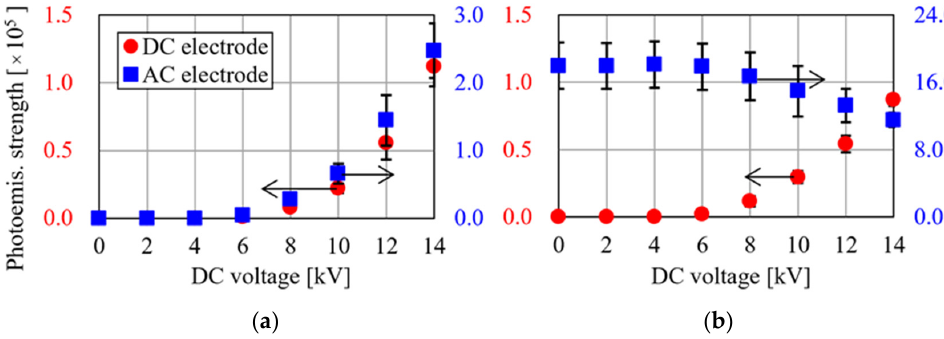
Figure 13. Photoemission strength versus the DC voltage when the AC voltage was 10 kV pp at 4 kHz in the ( a ) CD-PA and ( b ) TED-PA.